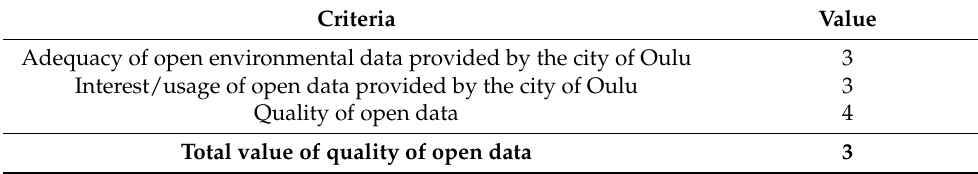
Table 8. The evaluated criteria for the quality of the open data. Criteria